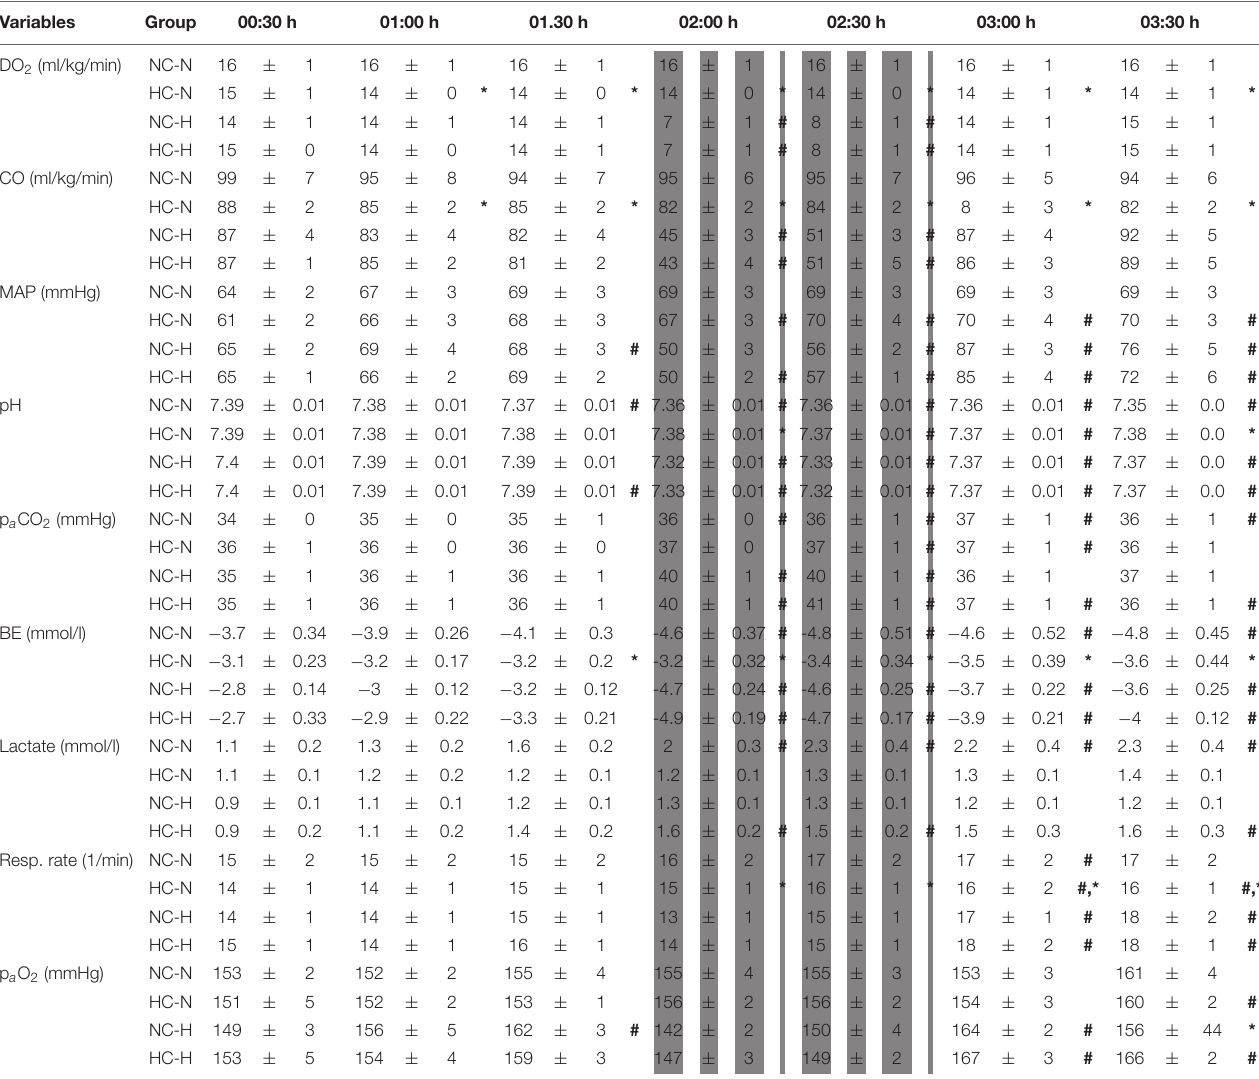
TABLE 2 | Macrocirculatory variables and blood gas analysis in normo- (NC) and hypercapnic (HC) animals during physiological (-N) or hemorrhagic (-H) conditions.